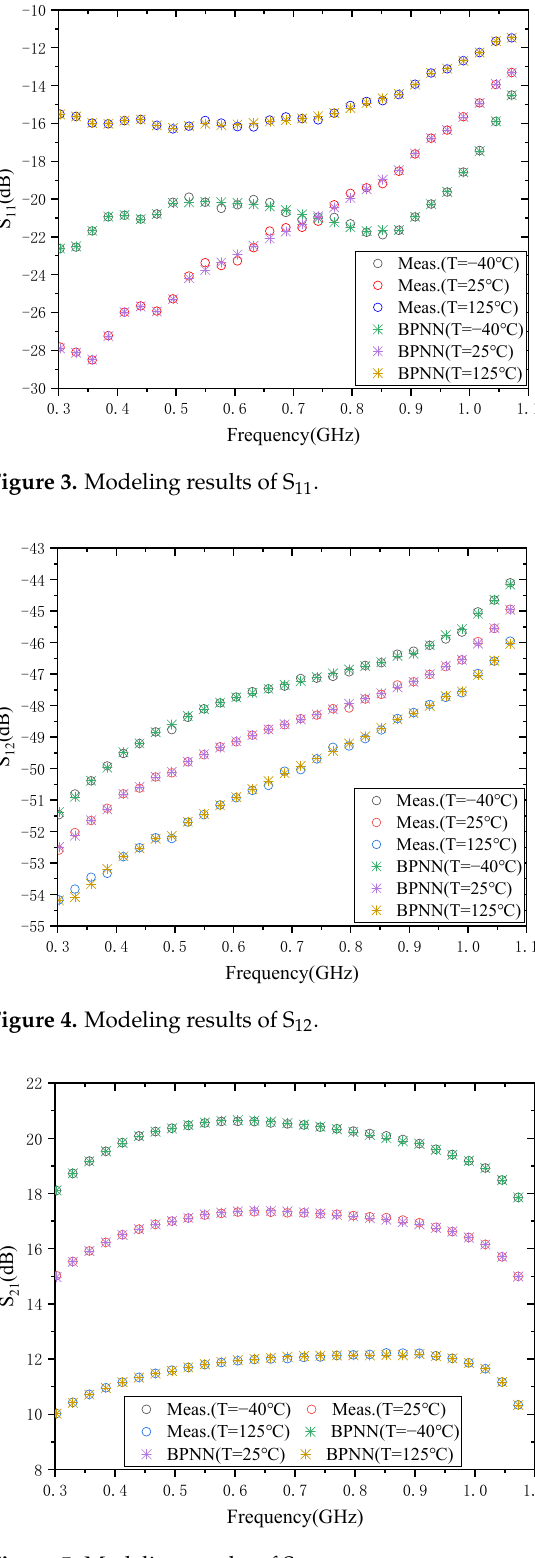
Figure 5. Modeling results of S 21 .